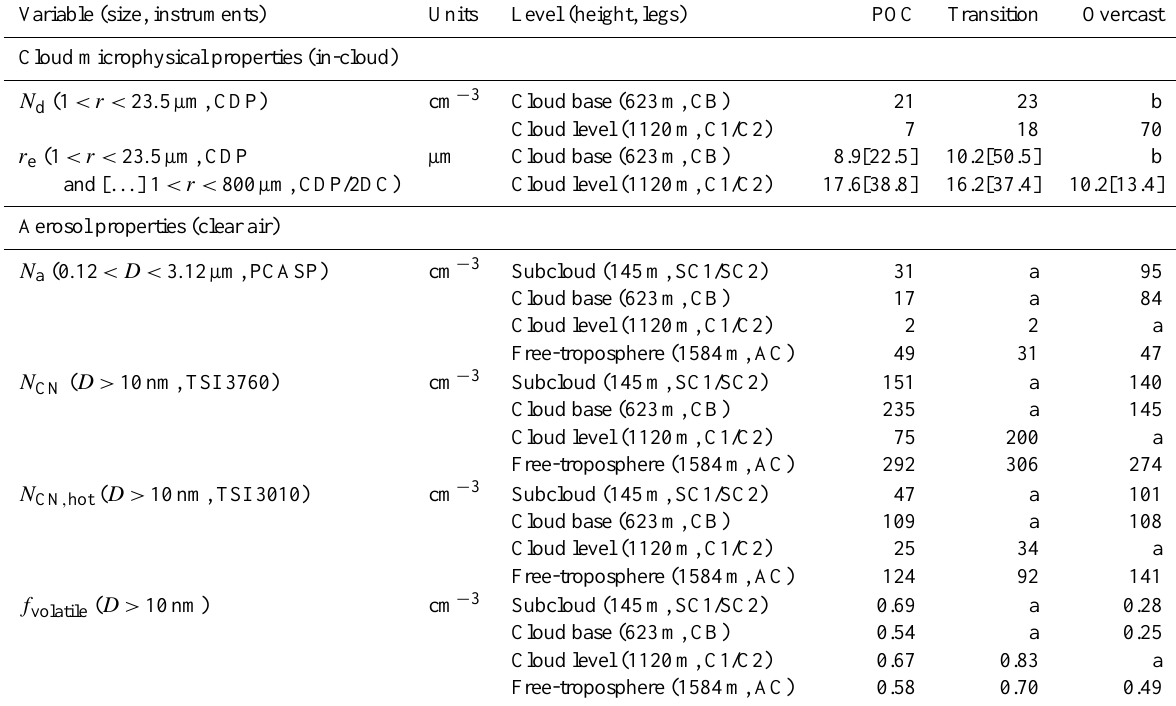
Table 5. Mean cloud microphysical parameters for the POC, overcast, and transition regions during RF06. Aerosol concentrations are mean values for drizzle-free clear-air samples, screened using the criteria described in Sect. 2.4. The volatile fraction f volatile is estimated from the leg means as (N CN − N CN , hot )/N CN . Cloud droplet and concentrations N d and effective radii r e are for cloudy samples only. A minimum of 20 samples (1Hz) is required to include a mean in the table; data for regions/levels with fewer than 20 samples are not presented. Variable (size, instruments) Units Level (height, legs) POC Transition Overcast Cloud microphysical properties (in-cloud) N d (1 <r < 23 . 5µm, CDP) cm − 3 Cloud base (623m, CB) Cloud level (1120m, C1/C2) Cloud base (623m,